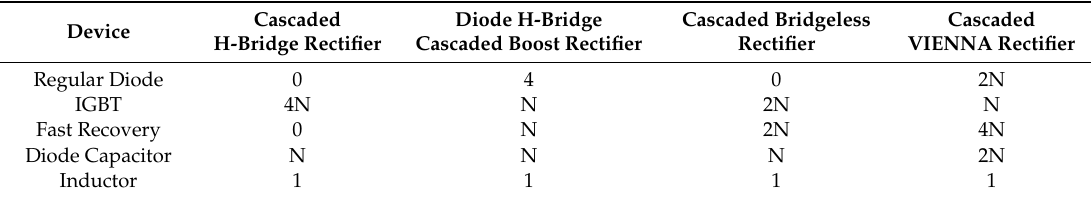
Table 2. Main electrical power component count for rectifier topologies.